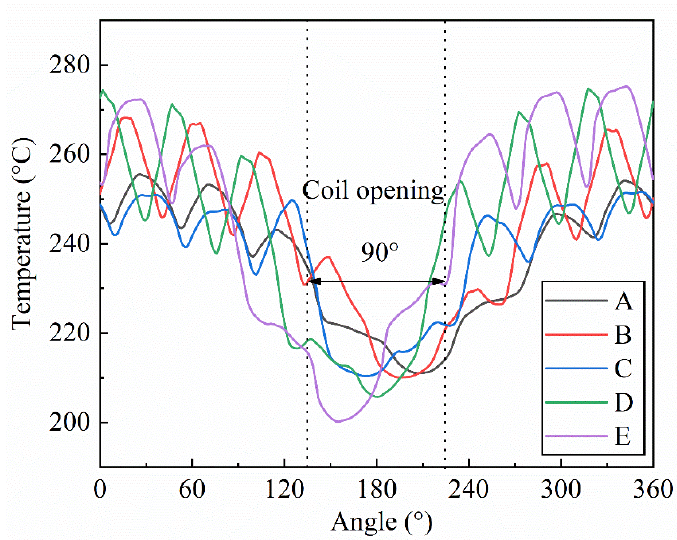
Figure 11. Temperature distribution of the gear tooth surface during TC heating.